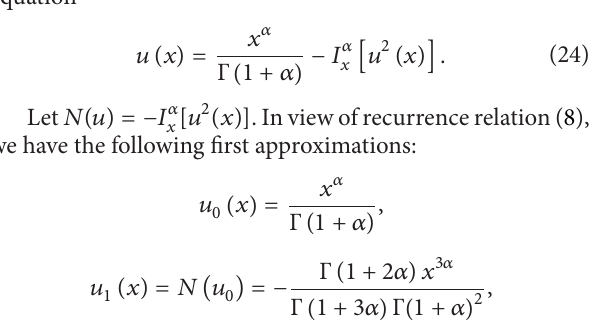
Figure 1: Plots of the approximate solution and the exact solution for